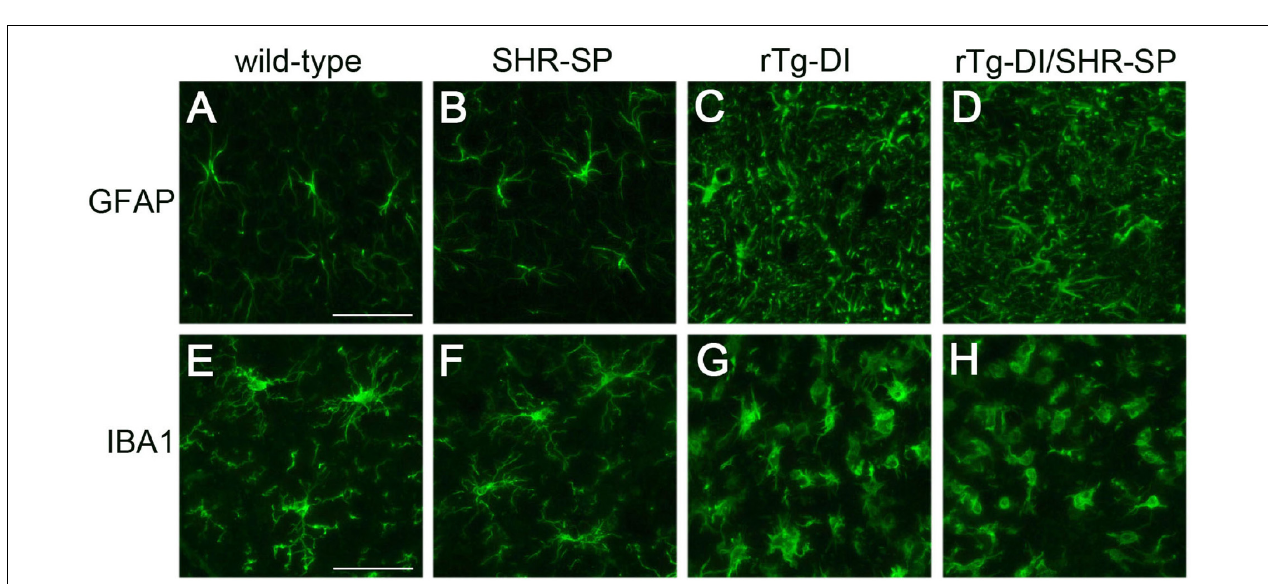
FIGURE 7 | CAA loads in 10 M rTg-DI rats and bigenic rTg-DI/SHR-SP rats. Representative images of brain sections from 10 M old rTg-DI rats (A,C,E,G) and bigenic rTg-DI/SHR-SP rats (B,D,F,H) were stained for fibrillar amyloid using thioflavin-S (green) and immunolabeled for collagen type IV to identify cerebral vessels (red). Scale bars = 50 µ M. (I) Quantitation of thioflavin-S positive vascular amyloid load in different brain regions of rTg-DI rats (red circles) and bigenic rTg-DI/SHR-SP rats (blue circles). Data shown are mean ± S.D of n = 6–7 rats per group. Unpaired, two tailed t -tests show a significant decrease in CAA load in the hippocampus and thalamus of bigenic rTg-DI/SHR-SP rats compared to that of rTg-DI, both comparisons with p -values of P < 0.05. Contrarily, surface pial vessel coverage is significantly increased bigenic rTg-DI/SHR-SP rats compared to rTg-DI where P < 0.05. These data indicate a change in CAA load in when introducing the rTg-DI transgene onto the SHR-SP hypertensive background.